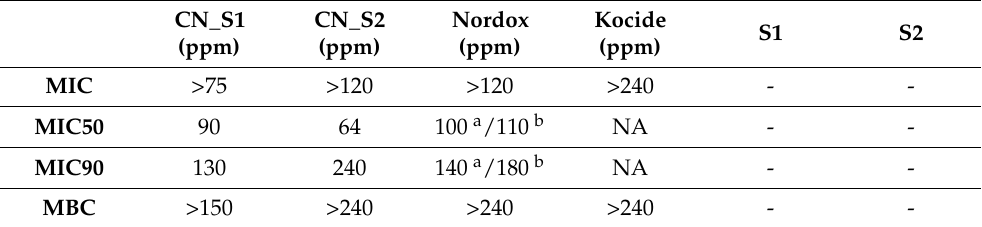
Figure 1. Dose–response effect of two copper nanoparticles at increasing concentrations against the bacterial pathogen X. c. pv. Vesicatoria : ( A ) CN_S2, CN_S2_X1 and ( B ) CN_S1, CN_S1_X1. Respective stabilizers S1 and S2 and water treatment were used as controls, while Nordox and Kocide were used as reference compounds. Effect was evaluated in OD 600 at 0, 24 and 48 h post inoculation (hpi) using a multi-detection microplate reader. Estimated marginal means and their standard errors for three independent experiments of triplicate data sets are plotted here. Different letters (a–k) represent statistically different data points at p ≤ 0.05 according to Tukey post hoc comparisons. Comparisons are between all treatments and time points. Brackets and arrows indicate bars in the same statistical group. Table 1. Calculated MICs and MBCs of broth efficacy tests of CuNPs for X. c. pv. vesicatoria